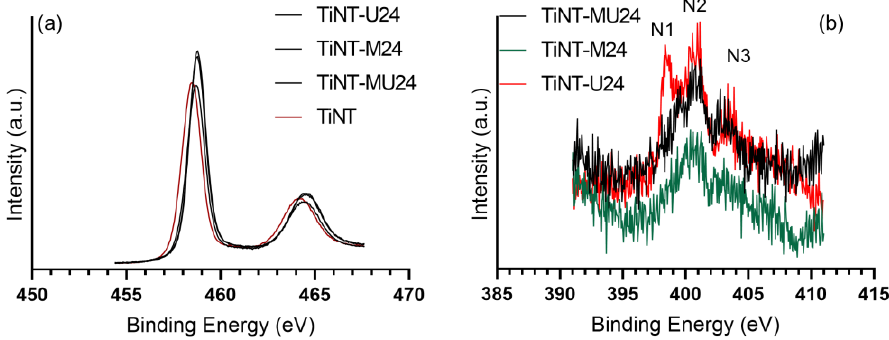
Figure 5. Comparison of ( a ) Ti2p and ( b ) N1s high-resolution XPS spectra for g-C 3 N 4 /TiNT composites prepared from 24·10 −3 mol concentration of precursors.